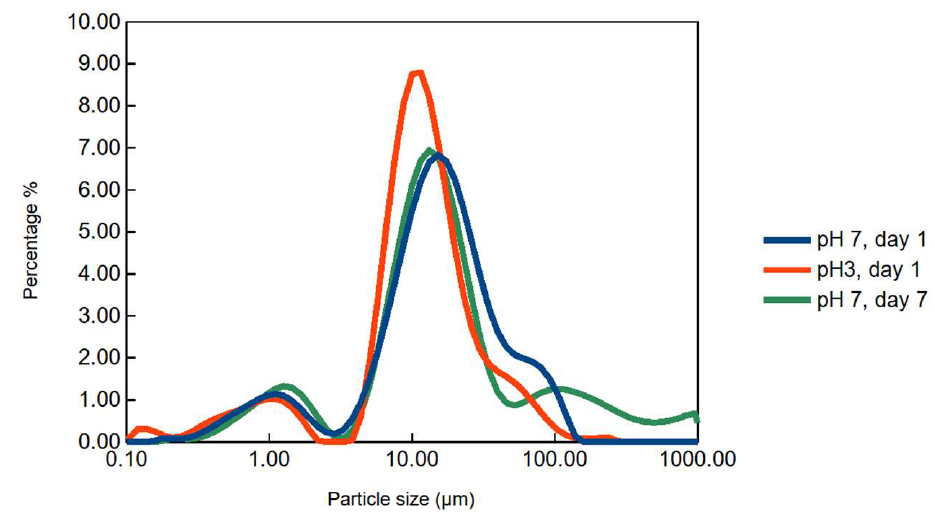
Figure 3. Size distributions of particles for emulsions prepared with 1% BE at pH 7 (blue) and at pH 3 (red). The size distribution of particles at pH7, 7 days after preparation is also shown in green.